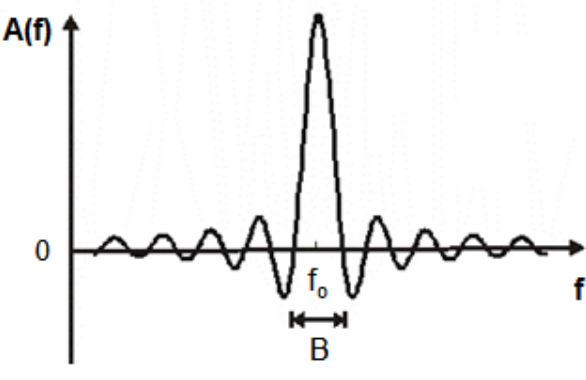
Figure 3. Frequency response of an IDT (positive